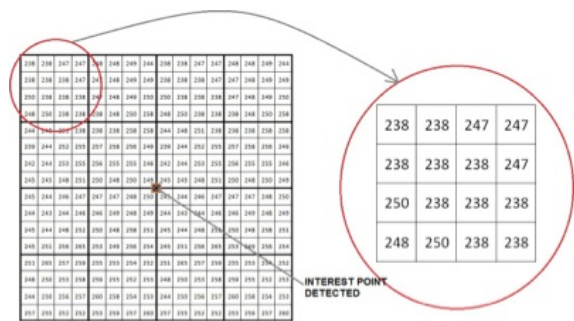
Figure 7: Extraction of